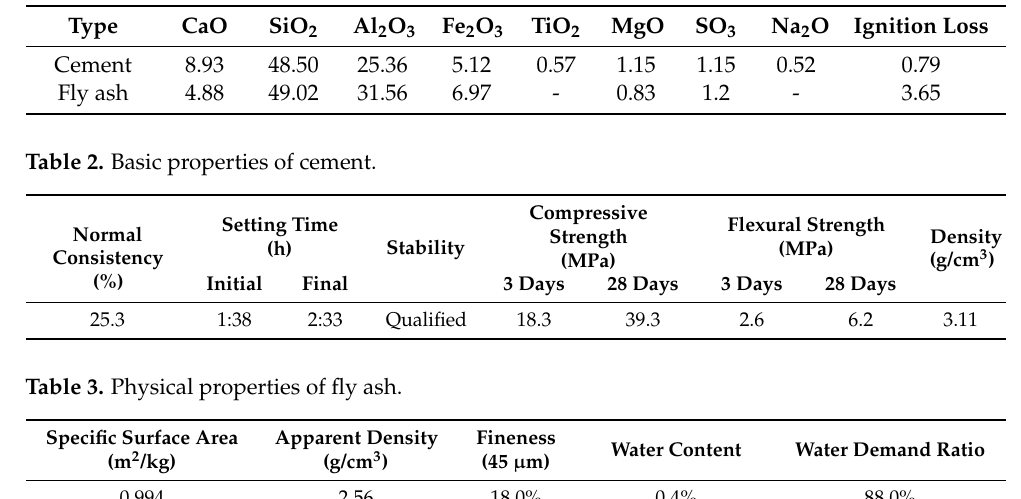
Table 1. Chemical composition of cement (%).